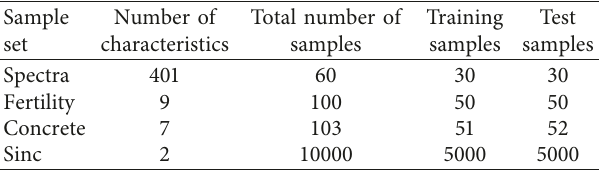
Table 2: Data set description of the selected UCI regression problems.